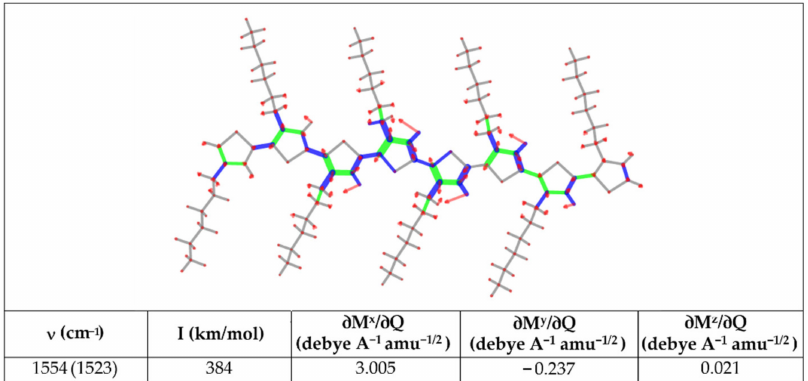
Figure 5. Computed vibrational displacements associated with the antisymmetric C=C stretching mode of a 3H8T molecule. This mode corresponds to the IR band observed at 1510 cm − 1 (same wavenumber for the 3H8T oligomer and the P3HT polymer, see reference [63]). Computed values of the unscaled and scaled (in parenthesis) vibrational wavenumber, IR intensity, and associated dipole derivative vector are reported. Calculations have been carried out with density functional theory (DFT) simulations at B3LYP/6-31G(d,p) level; details in reference [63]. Red arrows represent displacement vectors; CC bonds are represented as green and blue lines of different thicknesses according to their relative stretching (shrinking).